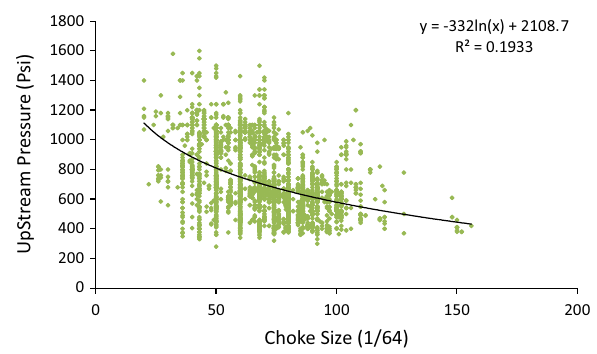
Fig. 3 Wellhead pressure versus choke size of the raw